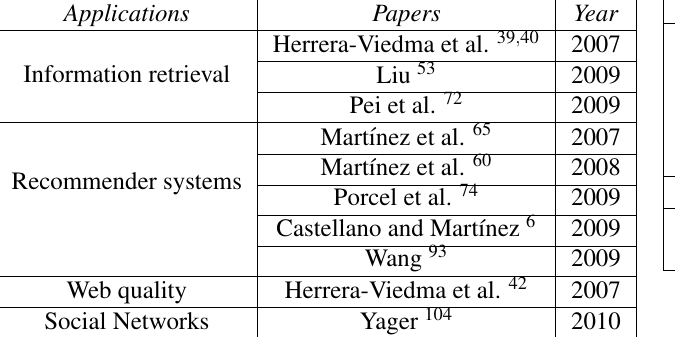
Table 2. Internet based linguistic applications